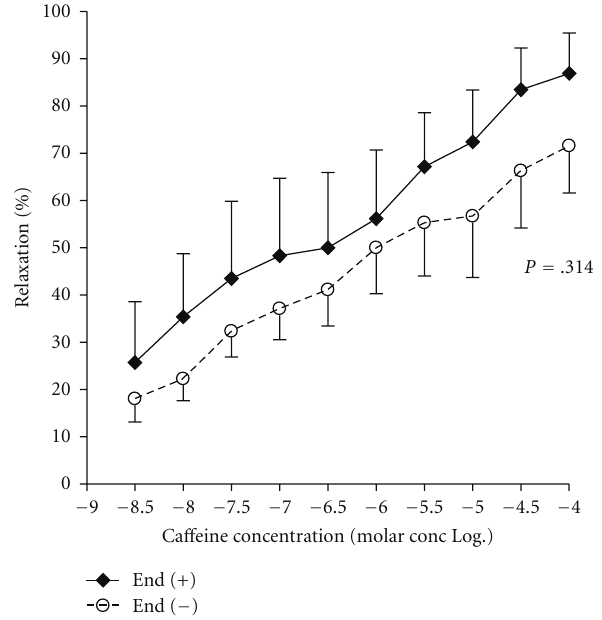
Figure 1: Relaxation of human arteries in the presence of increasing doses of ca ff eine. End (+): normal endothelial function; End ( − ): endothelial dysfunction. The data are presented as average ± stan- dard error of the media, which is presented in only one direction to facilitate the reading of the figure. It is reproduced with the authorization of Biom´edica.